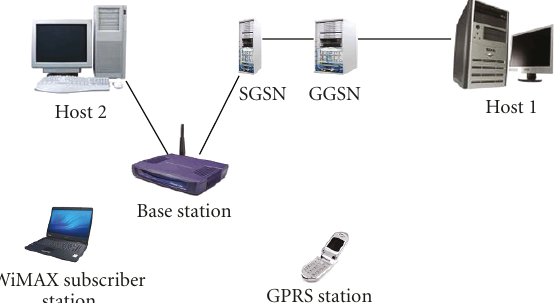
Figure 14: The topology of the simulated GPRS+WiMAX coexis- tence